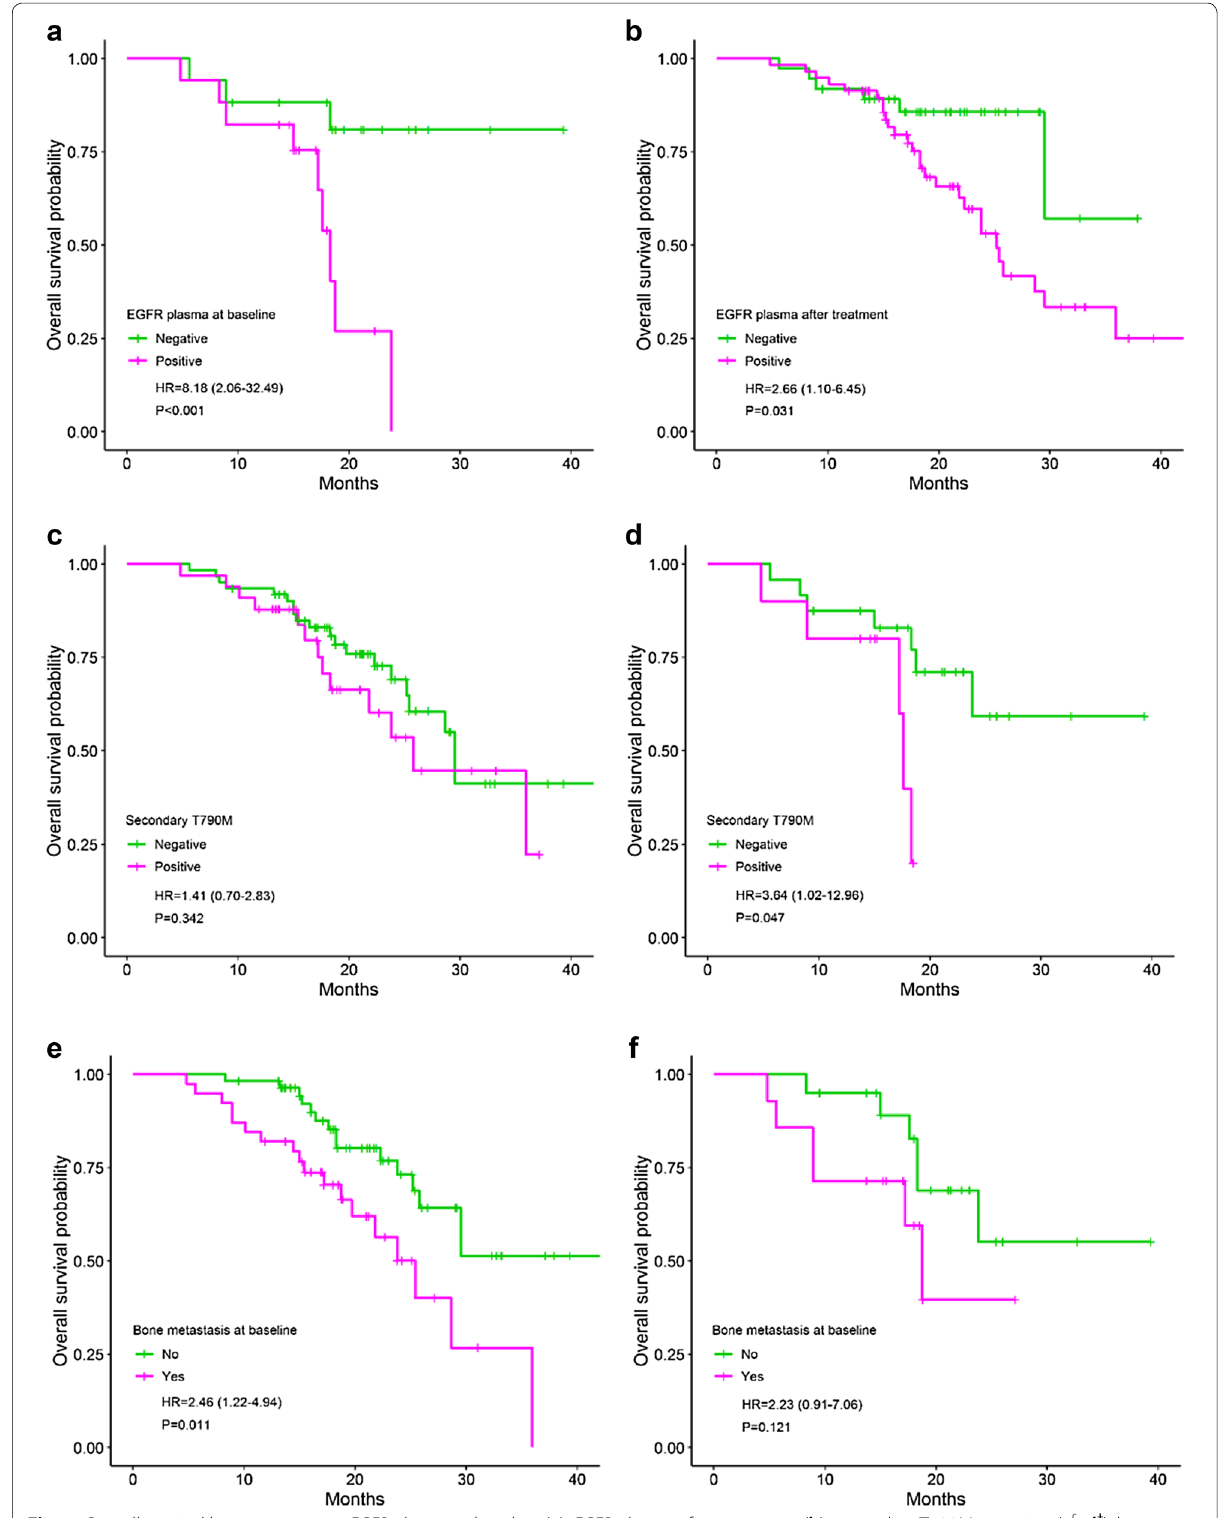
Fig. 5 Overall survival between groups: EGFR plasma at baseline ( a ); EGFR plasma after treatment ( b ); secondary T790M mutation ( c £ , d ǂ ); bone metastasis at baseline ( e £ , f ǂ ). £: all patients; ǂ : the newly diagnosed group. EGFR epidermal growth factor